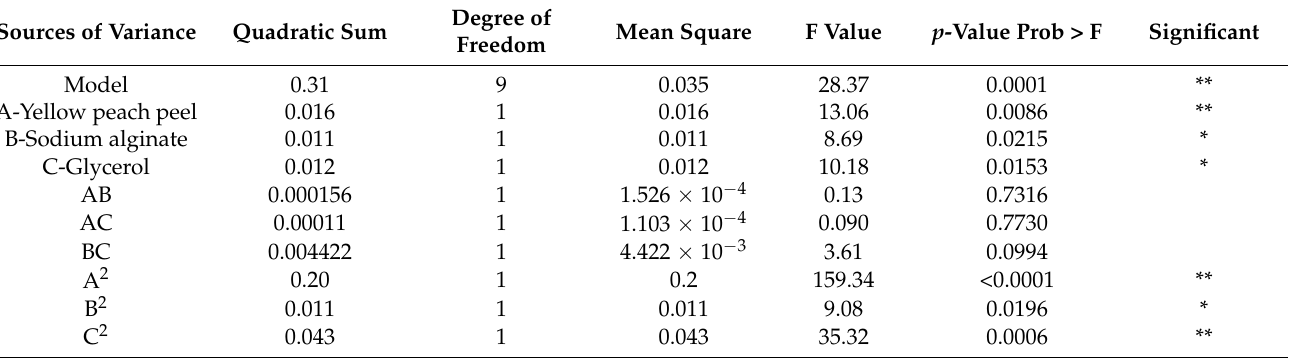
Table 5. Regression model analysis of variance table.